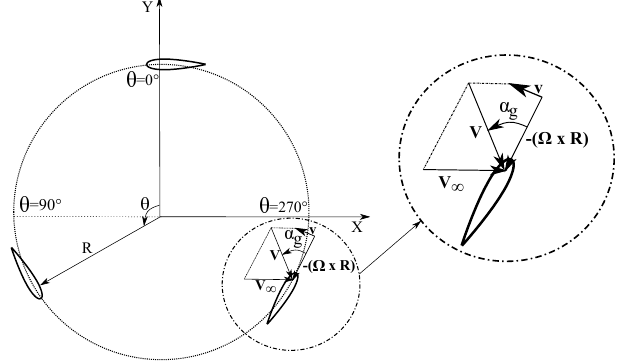
Figure 1. Two-dimensional view of a three-bladed rotor, showing the velocity